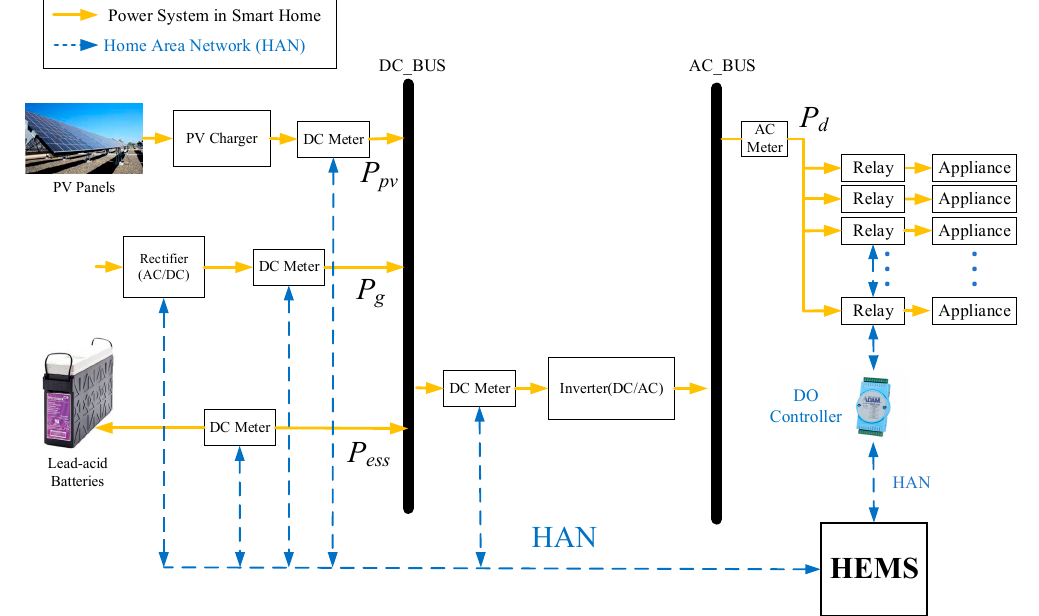
Figure 1. Structure of a power system monitored and controlled by home energy management system (HEMS).